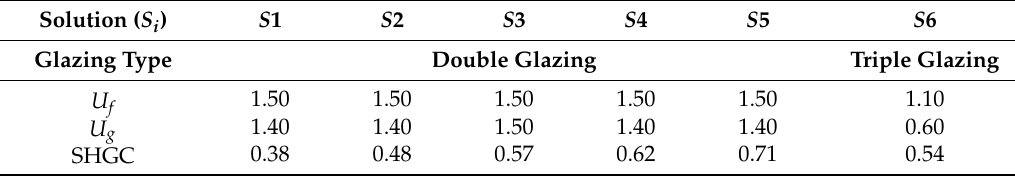
Table 6. Windows solutions (discrete